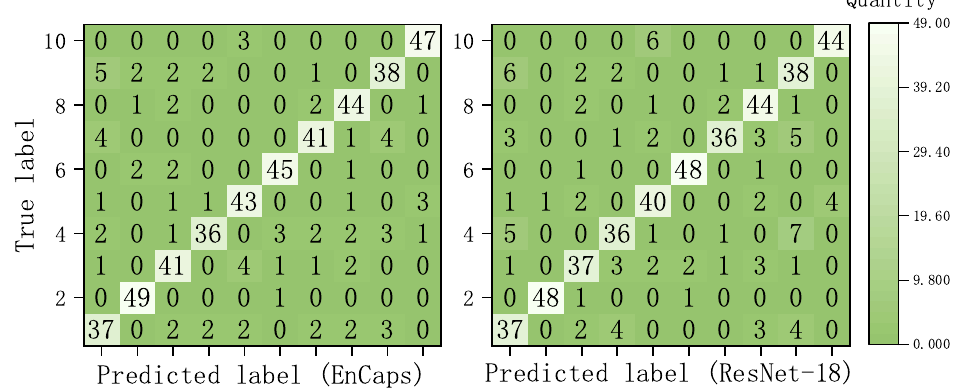
Figure 10. Performance comparison between EnCaps and ResNet-18 on the validation set.